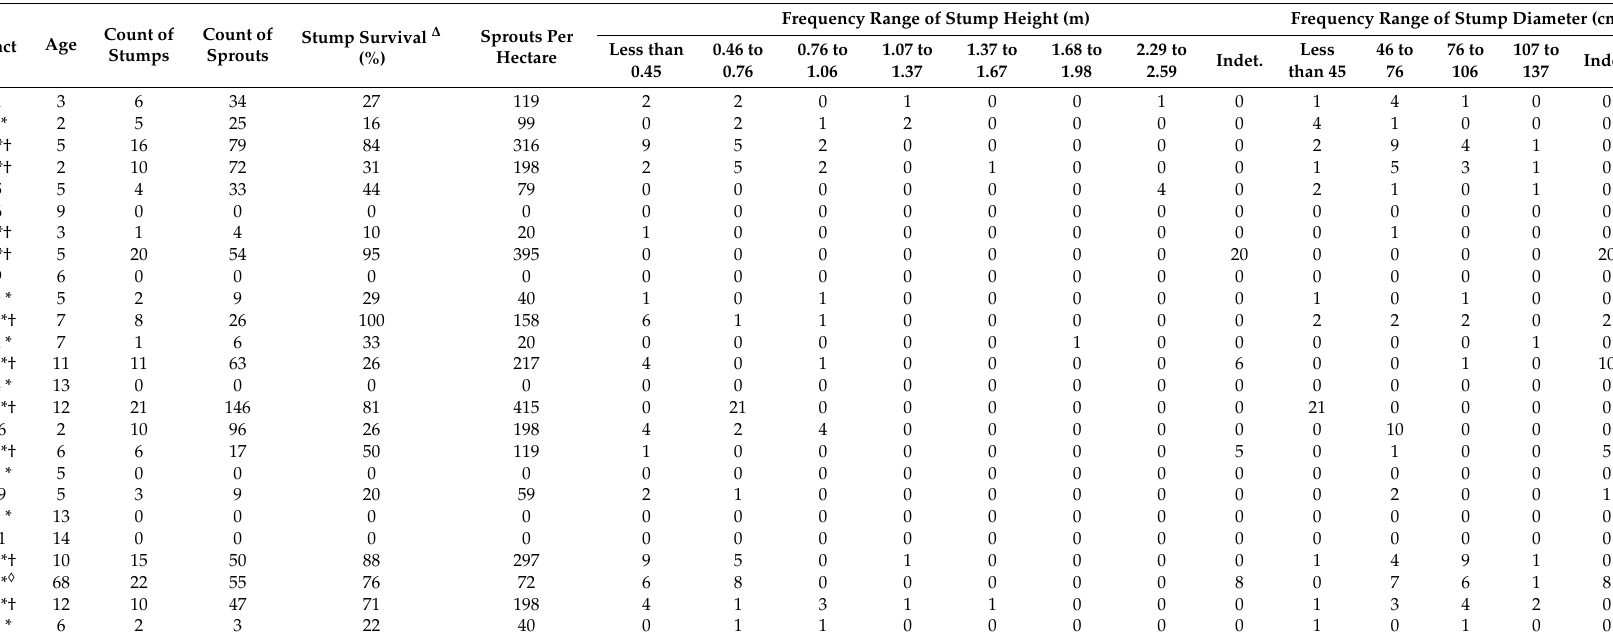
Table 6. Count, height, and diameter of live tupelo ( Nyssa species) stumps and percent of surviving stumps by each of the 25 tracts